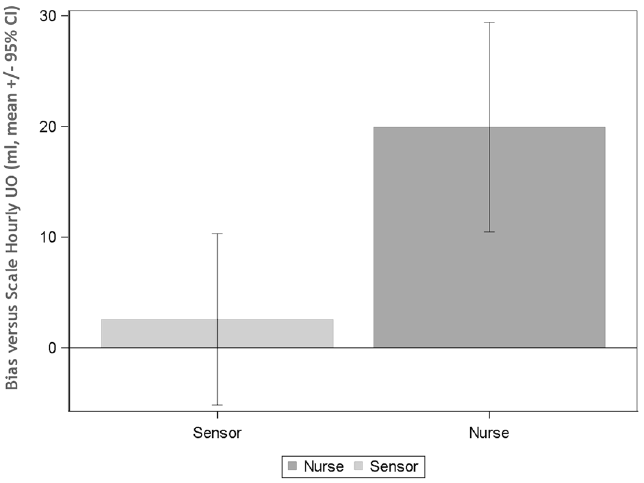
Figure 1. Comparison between manual and automated. Comparison of Urine output documented in the electronic medical record by the bedside nurse and sensor measurements to the hourly scale measurements (gold standard) by study personnel.